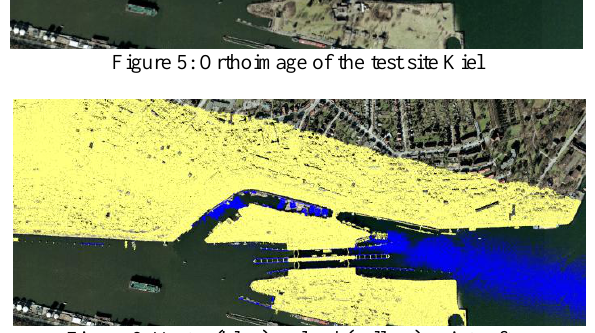
Figure 6: Water (blue) an land (yellow) points after classification by height, intensity, point density